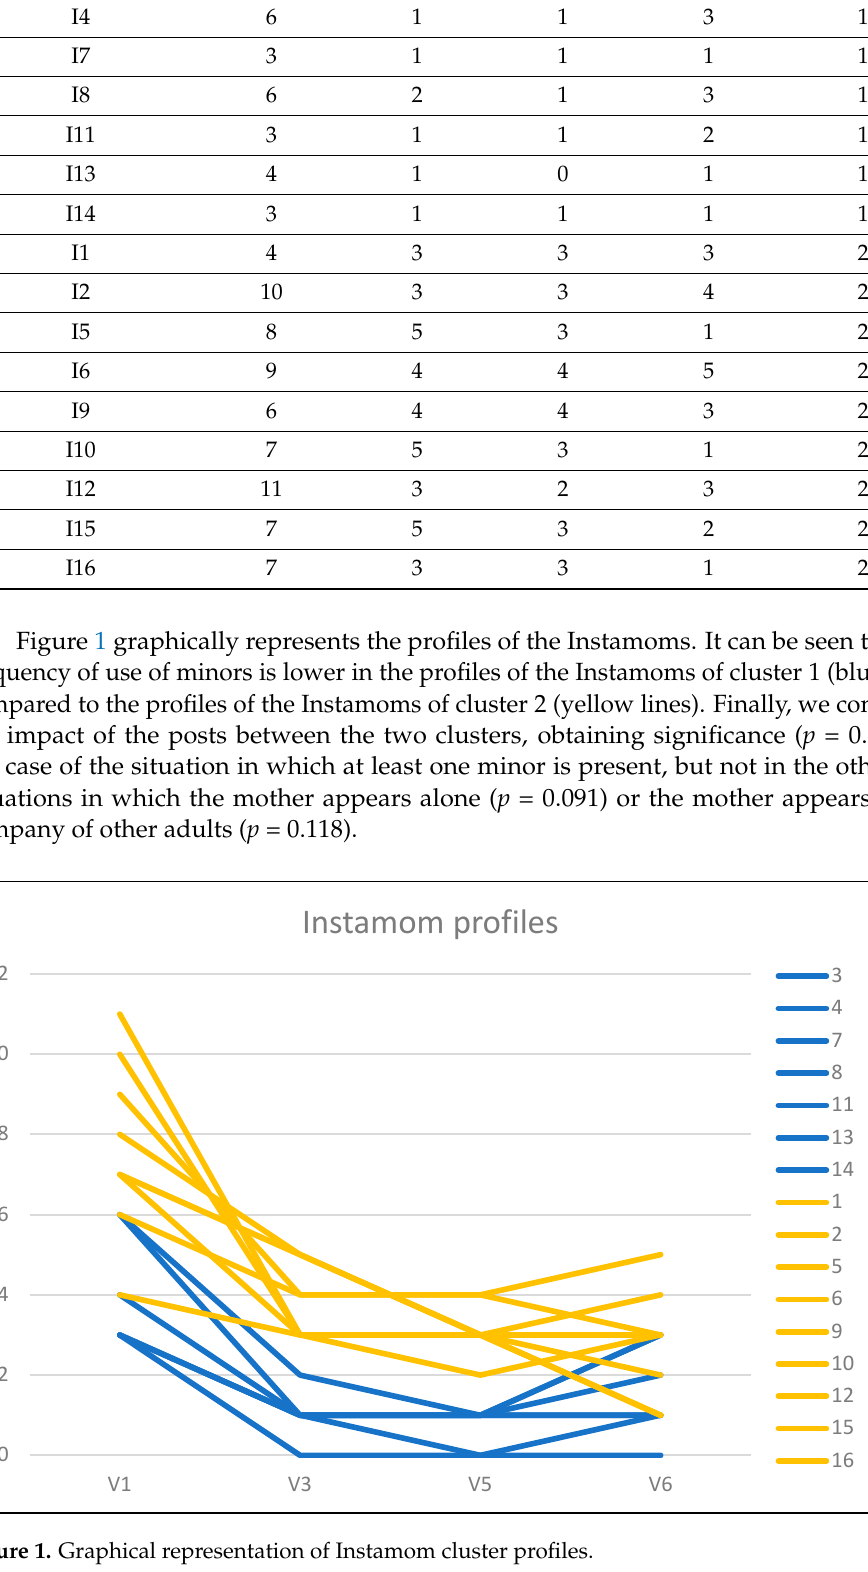
Table 3. The assignment of the Instamoms to two clusters depending on the quantification of the variables represented in Table 1.